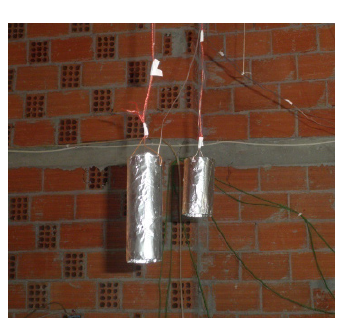
Figure 5. Thermocouples that measure at a distance from the glass.